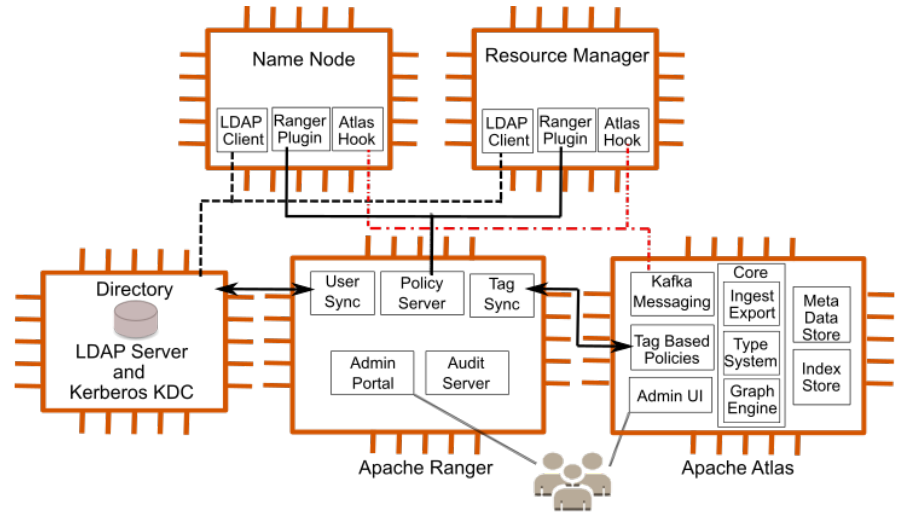
Figure 6. Apache Ranger and Atlas interfaces to HDFS Name Node and YARN Resource Manager. Directory information exchanges indicated by black dashed lines, Ranger policy information ex- changes are indicated by solid black lines, Atlas attribute tag information exchanges are indicated by dashed red lines, and synchronizations between the directory, Ranger and Atlas are indicated by double headed arrows.